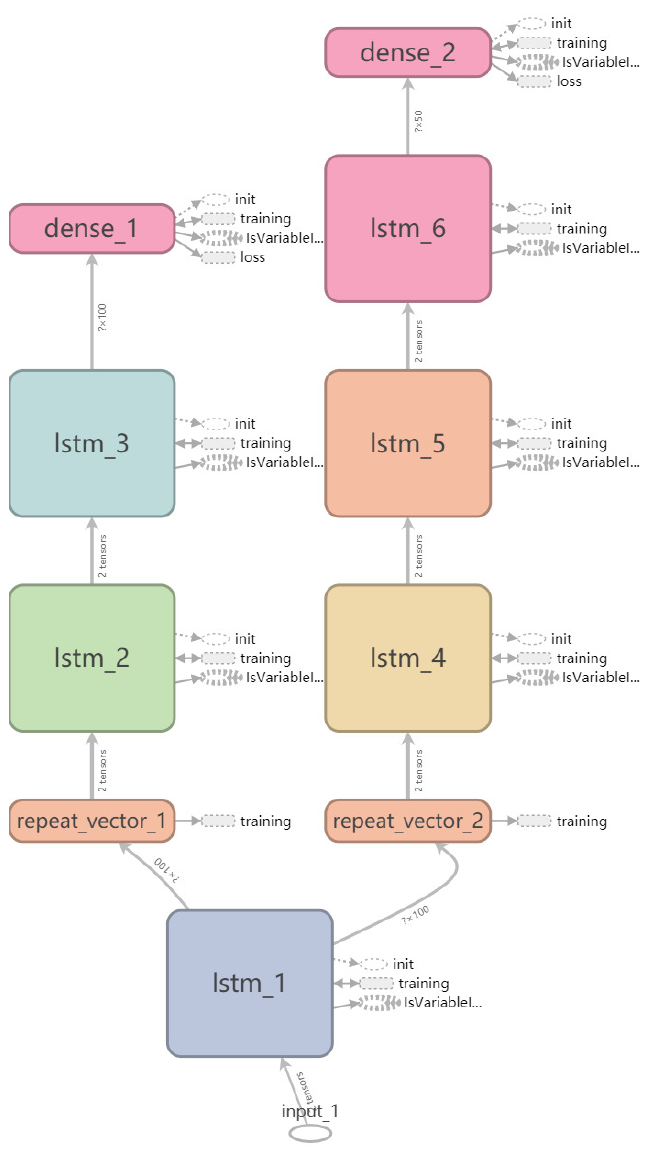
Figure 3. Architecture for LSTM with